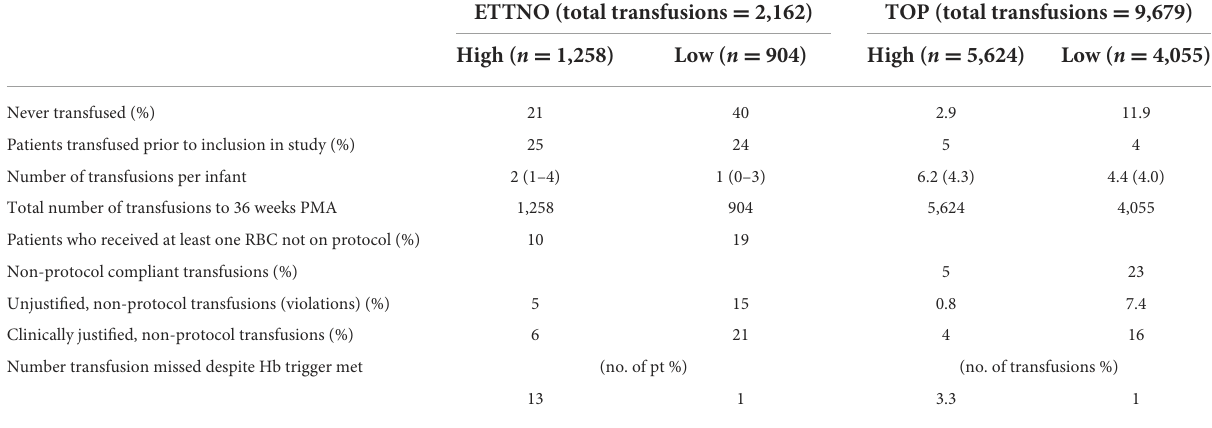
TABLE 4 Transfusion outcomes comparing ETTNO and TOP studies in the high and low threshold groups. Results shown as median (IQR) or mean (SD). ETTNO (total transfusions = 2,162) TOP (total transfusions = 9,679) High ( n =